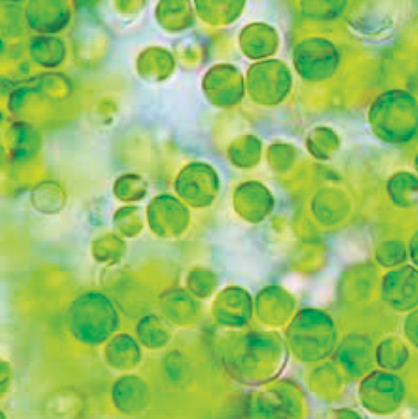
Figure 1: Microalgae ( Cholera vulgaris